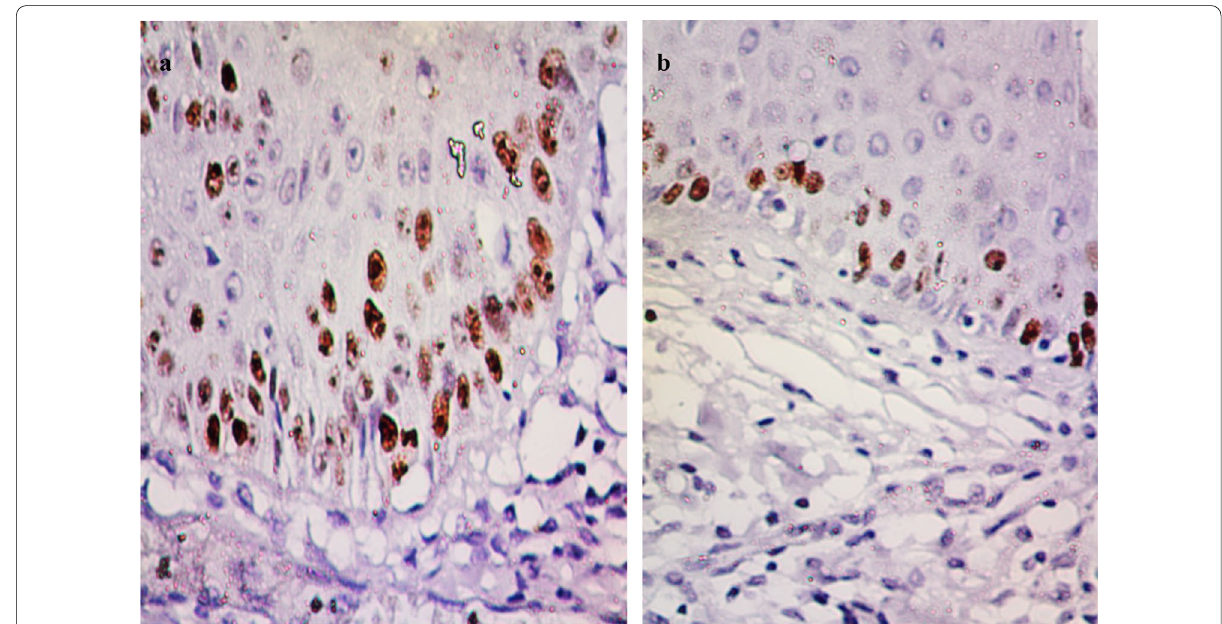
Fig. 5 Photomicrograph of Ki-67 immunoexpression showing a positive immunostaining of basal and suprabasal cells, b positive immune staining of some basal cells and negative immune staining of others (